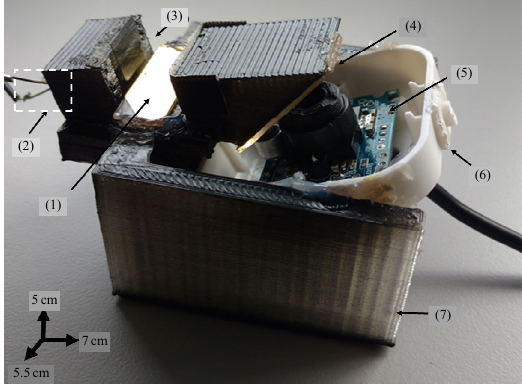
Fig. 5 Realized SPR system integrated with spectrometer along with components assembled on the 3D printed